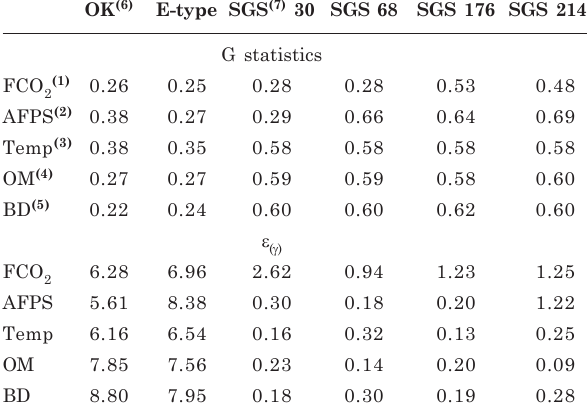
Table 3. Evaluation of the goodness-of-fit (G statistics) of the probability density function and accuracy in the reproduction of the variogram ( εεεεε ( γγγγγ ) )